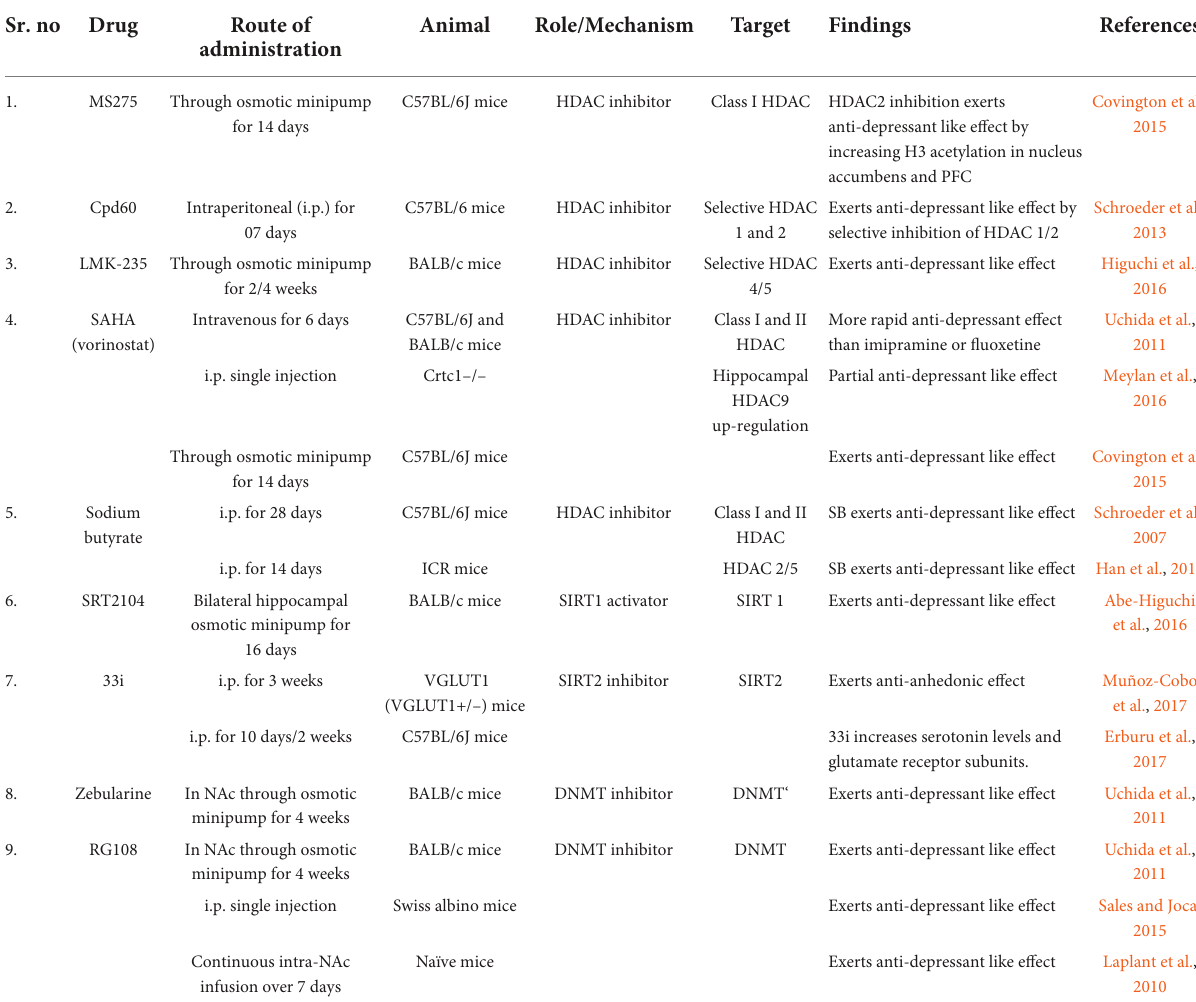
TABLE 2 Epigenetic drugs in